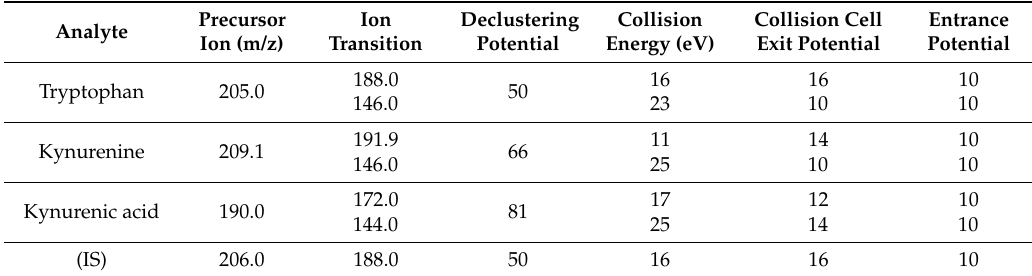
Table 6. Precursor ions and fragment ions of tryptophan, kynurenine, kynurenic acid and internal standards—mass spectrometry